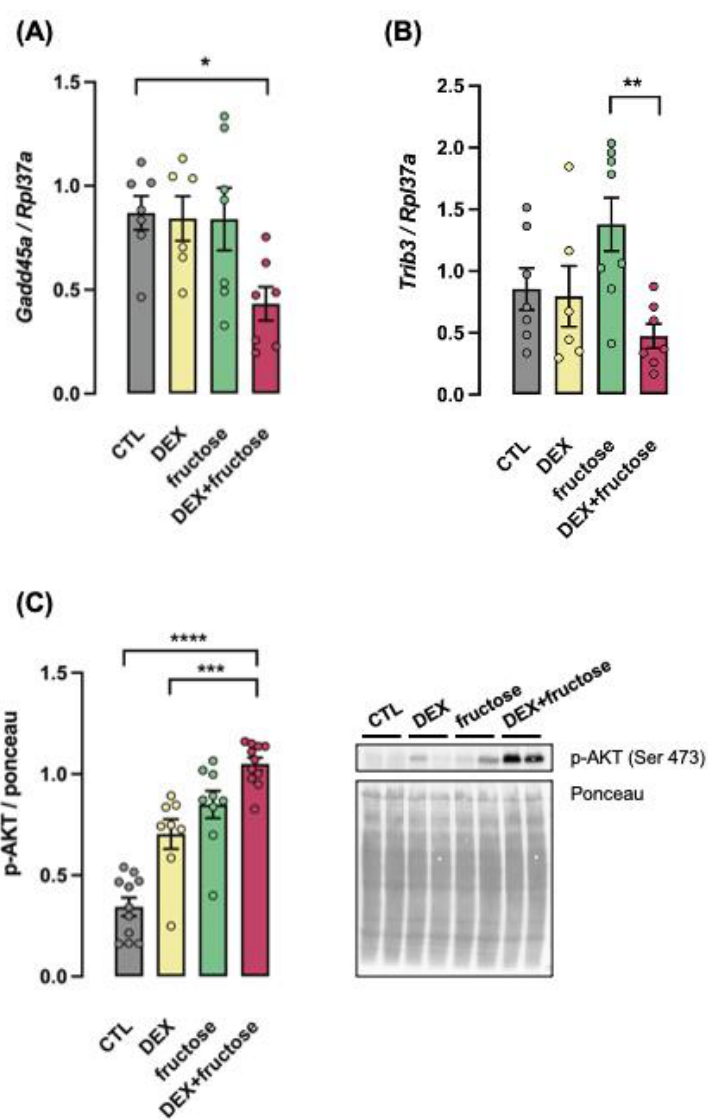
Figure 6. Fructose consumption induced changes in HCC in the liver of rats born to DEX-treated mothers. Liver fragments were removed from adult rats supplemented (fructose and DEX+fructose groups) or not (CTL and DEX groups) with fructose for 8 weeks. One set of samples was processed for RNA extraction and qPCR detection of Gadd45a ( A ) and Trib3 ( B ) expressions. Another set of samples was processed for Western blot detection of phosphorylated AKT ( C ). In the latter, band intensities were normalized by the signal from Ponceau staining. Data are presented as the mean ± SEM; * p < 0.05, ** p < 0.01, *** p < 0.001 and **** p < 0.001 vs. the group indicated by the bracket. In ( A ) and ( B ), n = 6 to 8; in ( C ), n = 8 to 11.